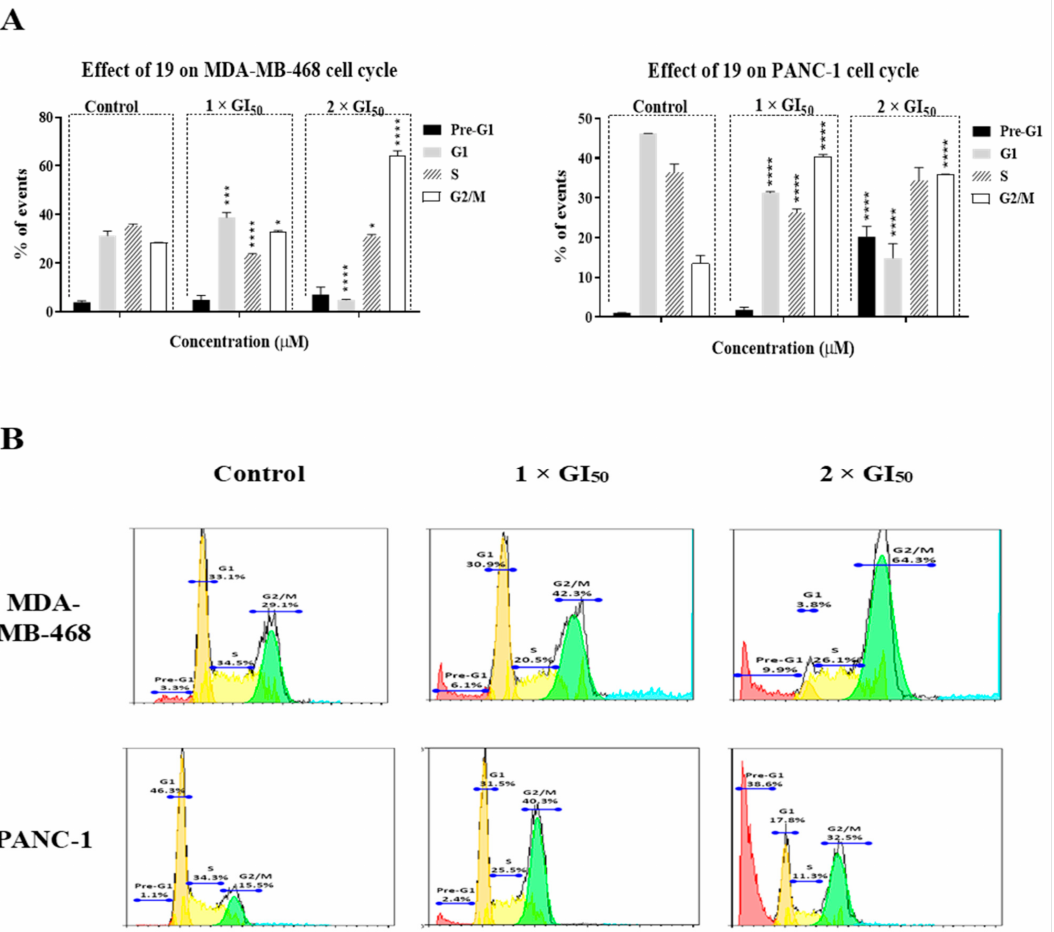
Figure 5. ( A ) Compound 19 induced gap 2 (G2)/mitosis (M) phase cell-cycle arrest in MDA-MB-468 and PANC-1 cells after 24 h of treatment at concentrations of 1 × GI 50 and 2 × GI 50 . The experiment was repeated at least three times. Bars and error bars refer to mean ± SD. * p < 0.05 vs. control, *** p < 0.001 vs. control, **** p < 0.0001 vs. control. ( B ) Representative cell-cycle histograms from one of the experiments showing the effect of 19 on cell-cycle progression in MDA-MB-468 and PANC-1 cells after 24 h of treatment at concentrations of 1 × GI 50 and 2 × GI 50